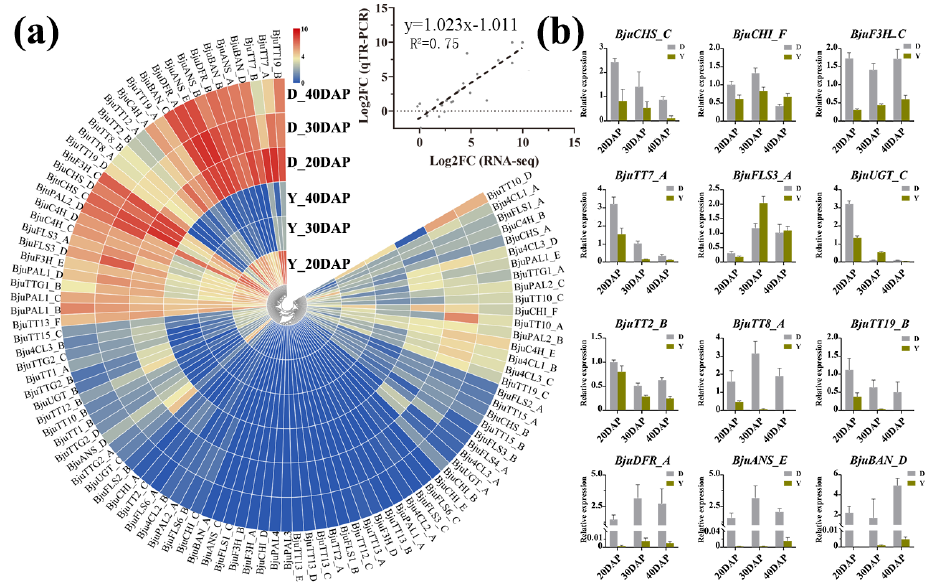
Figure 5. Analysis of the expression pattern of flavonoid genes in yellow and dark B. juncea seeds at various developmental stages. ( a ) Expression profiles of the flavonoid genes in yellow- and dark-seeded B. juncea at 20, 30, and 40 days after pollination (DAP). The scale bar denotes the log 2 (FPKM+1). The heatmap was generated using TBtools (version 1.055). The color represents relative gene expression levels. ( b ) RT-qPCR validation of flavonoid gene expression from the RNA-seq data at 20, 30, and 40 DAP. The candidate genes were named using the species abbreviation of the source organism (italicized), the gene family name, and the capital letter for the identified homologous, e.g., BjuTT1_A .